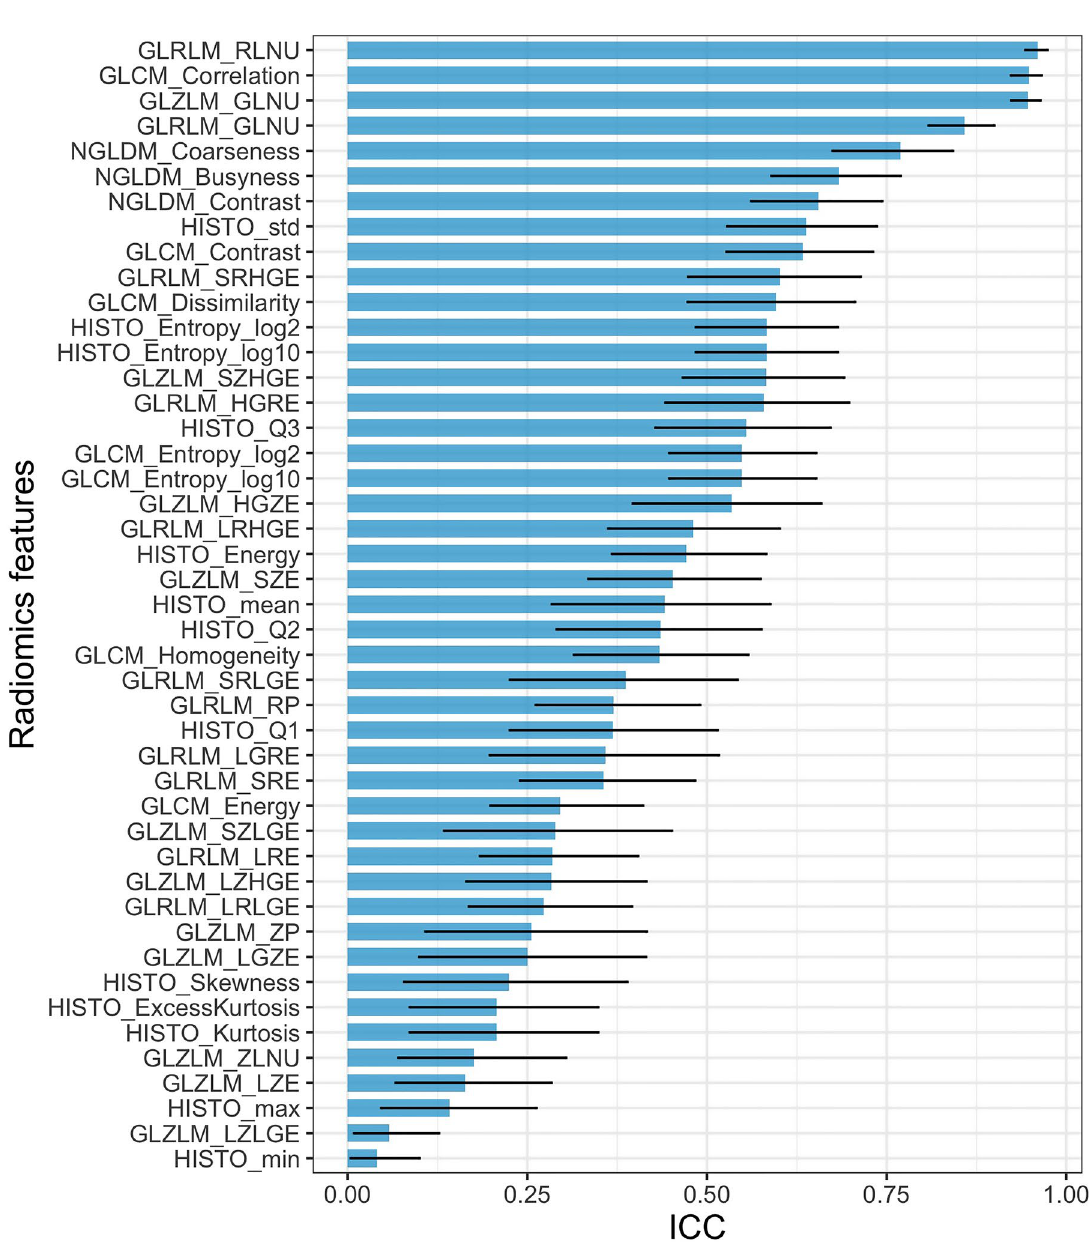
Figure 2. Intra-class correlation coefficients (ICC) of the radiomics features (RFs) depending on the intensity harmonization technique (IHT). Results are given with 95% confidence interval.